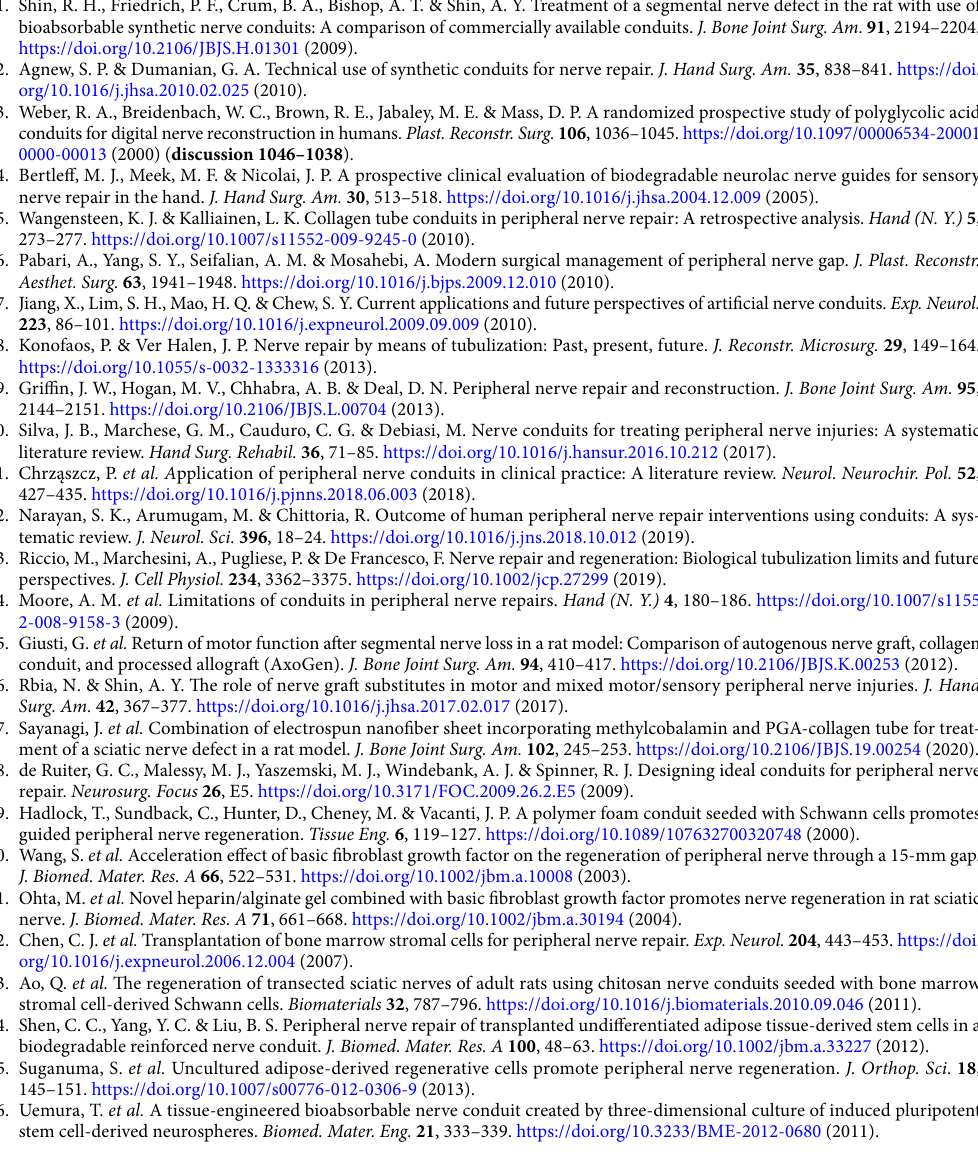
Figure 6. Representative optical microscope ( A – I ) and transmission electron microscope ( J – L ) images in the central transverse sections of the nerve conduits and grafted nerves 12 weeks after implantation. Immunohistochemistry for neurofilament protein antibody ( A – F ), and toluidine blue staining ( G – I ). ( A , D , G , J ) The control group. ( B , E , H , K ) The iPS group. ( C , F , I , L ) The autograft group. Axon numbers ( M ), axon areas ( N ), and the G-ratio ( O ) 12 weeks after implantation. *p < 0.05. ( M ) Control group: 220 ± 19 (vs. iPS group: p < 0.01, vs. autograft group: p < 0.01), iPS group: 355 ± 27 (vs. autograft group: p < 0.01), autograft group: 511 ± 30. ( N ) Control group: 1.3 ± 0.1 (vs. iPS group: p < 0.01, vs. autograft group: p < 0.01), iPS group: 2.2 ± 0.2 (vs. autograft group: p = 0.01), autograft group: 2.9 ± 0.2. ( O ) Control group: 0.74 ± 0.003 (vs. iPS group: p < 0.01, vs. autograft group: p < 0.01), iPS group: 0.70 ± 0.004 (vs. autograft group: p < 0.01), autograft group: 0.66 ±